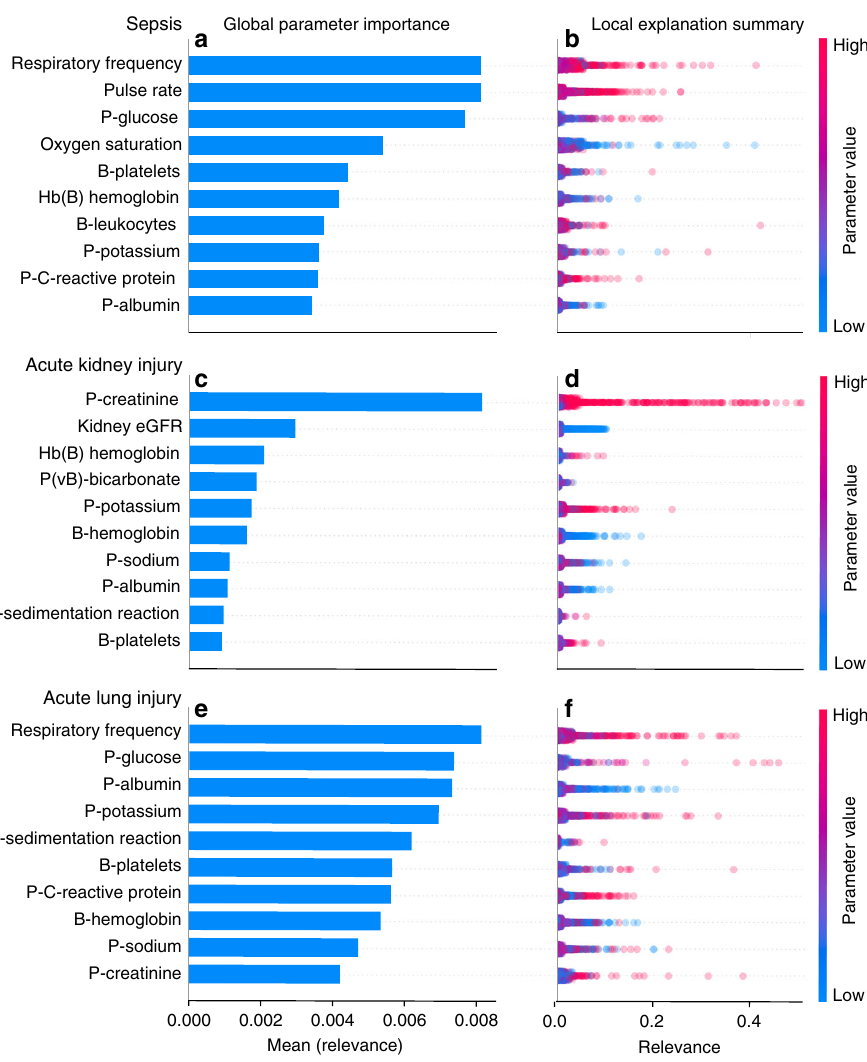
Fig. 4 Results from the explanation module displaying the global parameter importance and local explanation summary. The parameters are sorted in descending order according to global parameter importance, de fi ned by the mean relevance, which is identi fi ed by the blue horizontal bars for sepsis ( a ), AKI ( c ), and ALI ( e ). The local explanations summary shows all the individual data-points, colored by parameter value and displaced by the mean relevance for sepsis ( b ), AKI ( d ), and ALI ( f ). The height of the data-points shown for each parameter in the local explanation summary correlate with the number of data-points at the associated level of relevance. The population-based perspective is simpli fi ed by ignoring the temporal relevance variations, treating all data-points at different times equally. P, plasma; eGFR, estimated Glomerular fi ltration